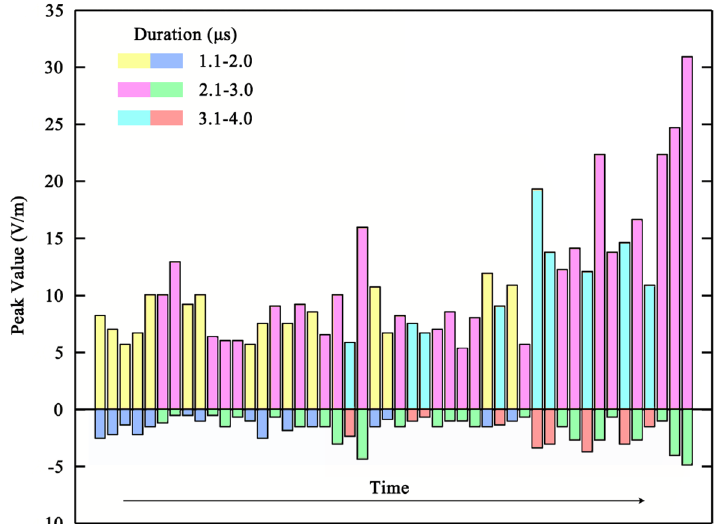
Figure 6. Features of 48 distinct bipolar pulses superimposed on the electric field at 1.55 km of DL14. The positive and negative peak values of these pulses are reflected by columns with colors representing their